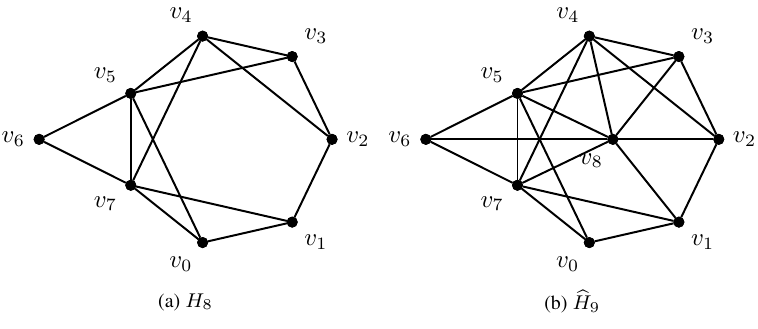
Fig. 4: The graph H